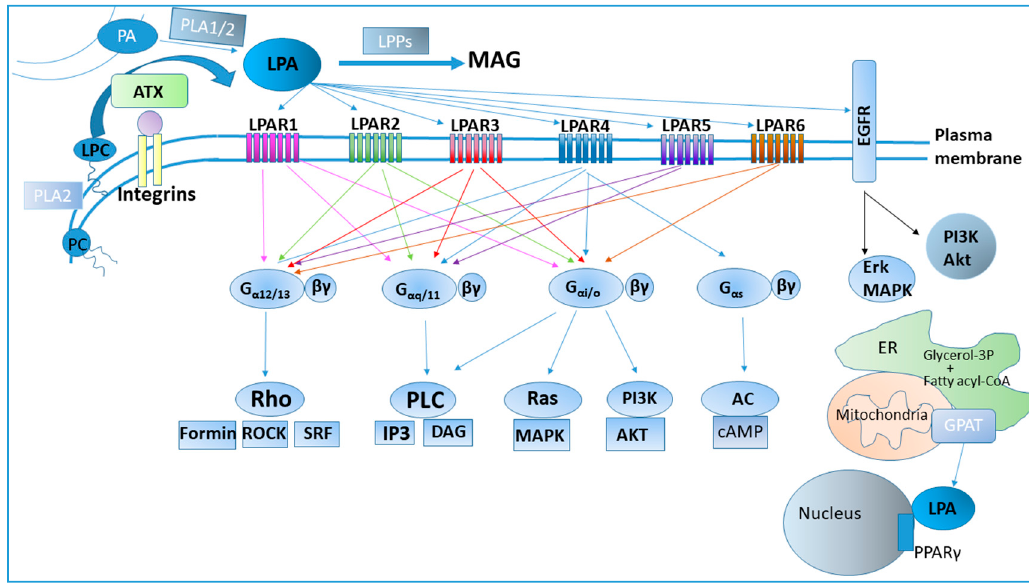
Figure 1. Lysophosphatidic acid (LPA) metabolism and signaling. AC: adenylyl cyclase; AKT: AKR